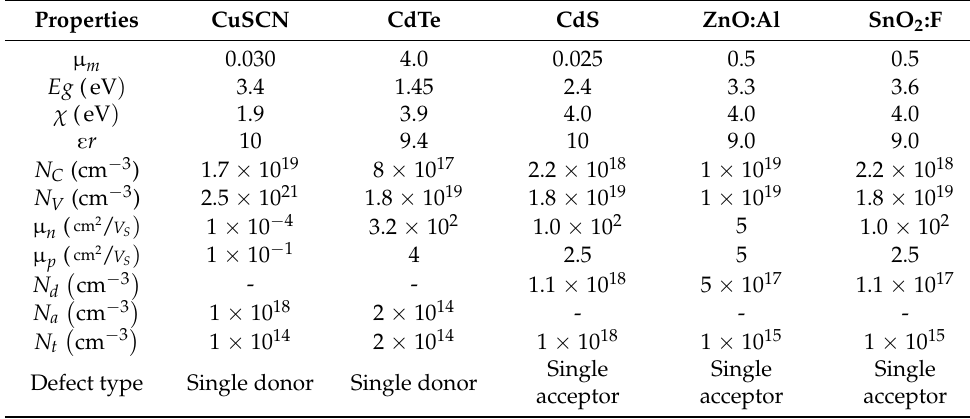
Table 1. Input parameters for the simulation of CdTe solar cell.